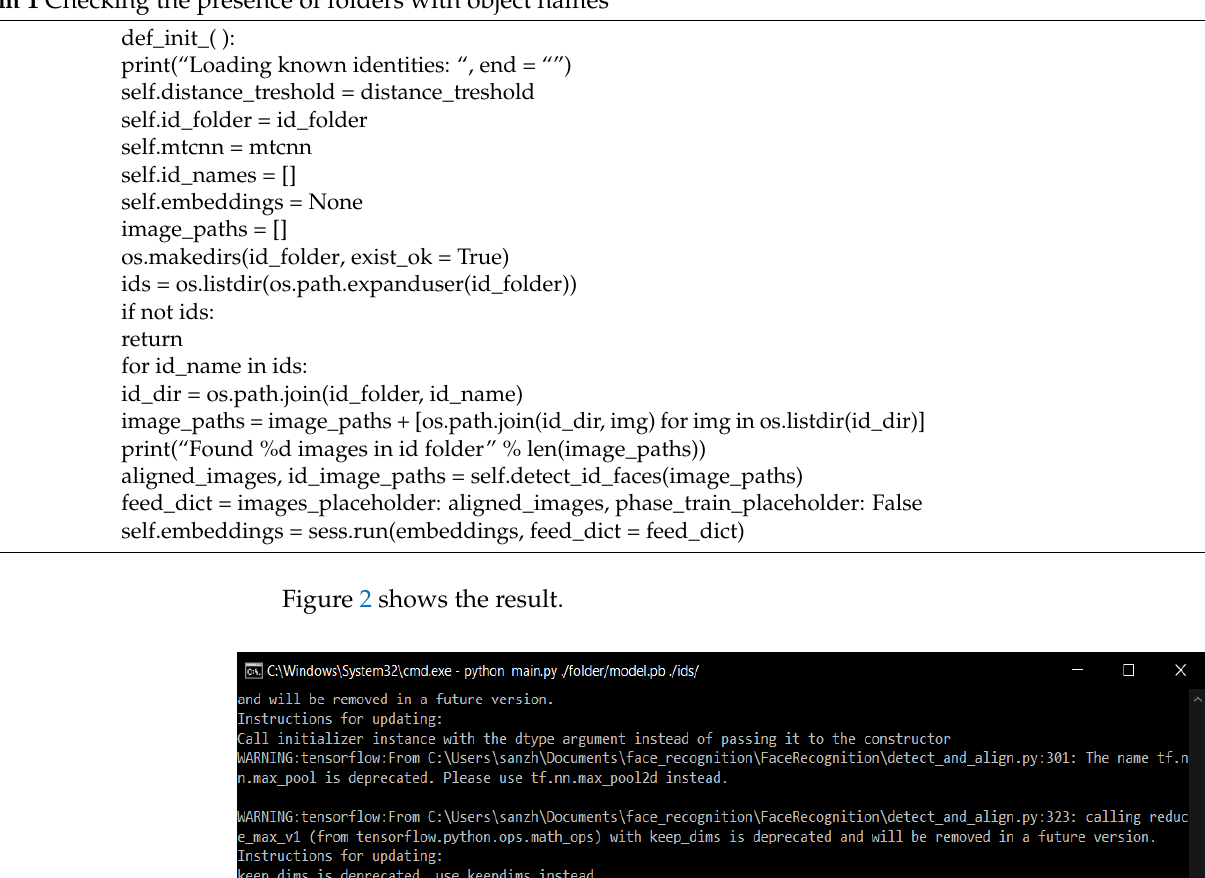
Algorithm 1 Checking the presence of folders with object names